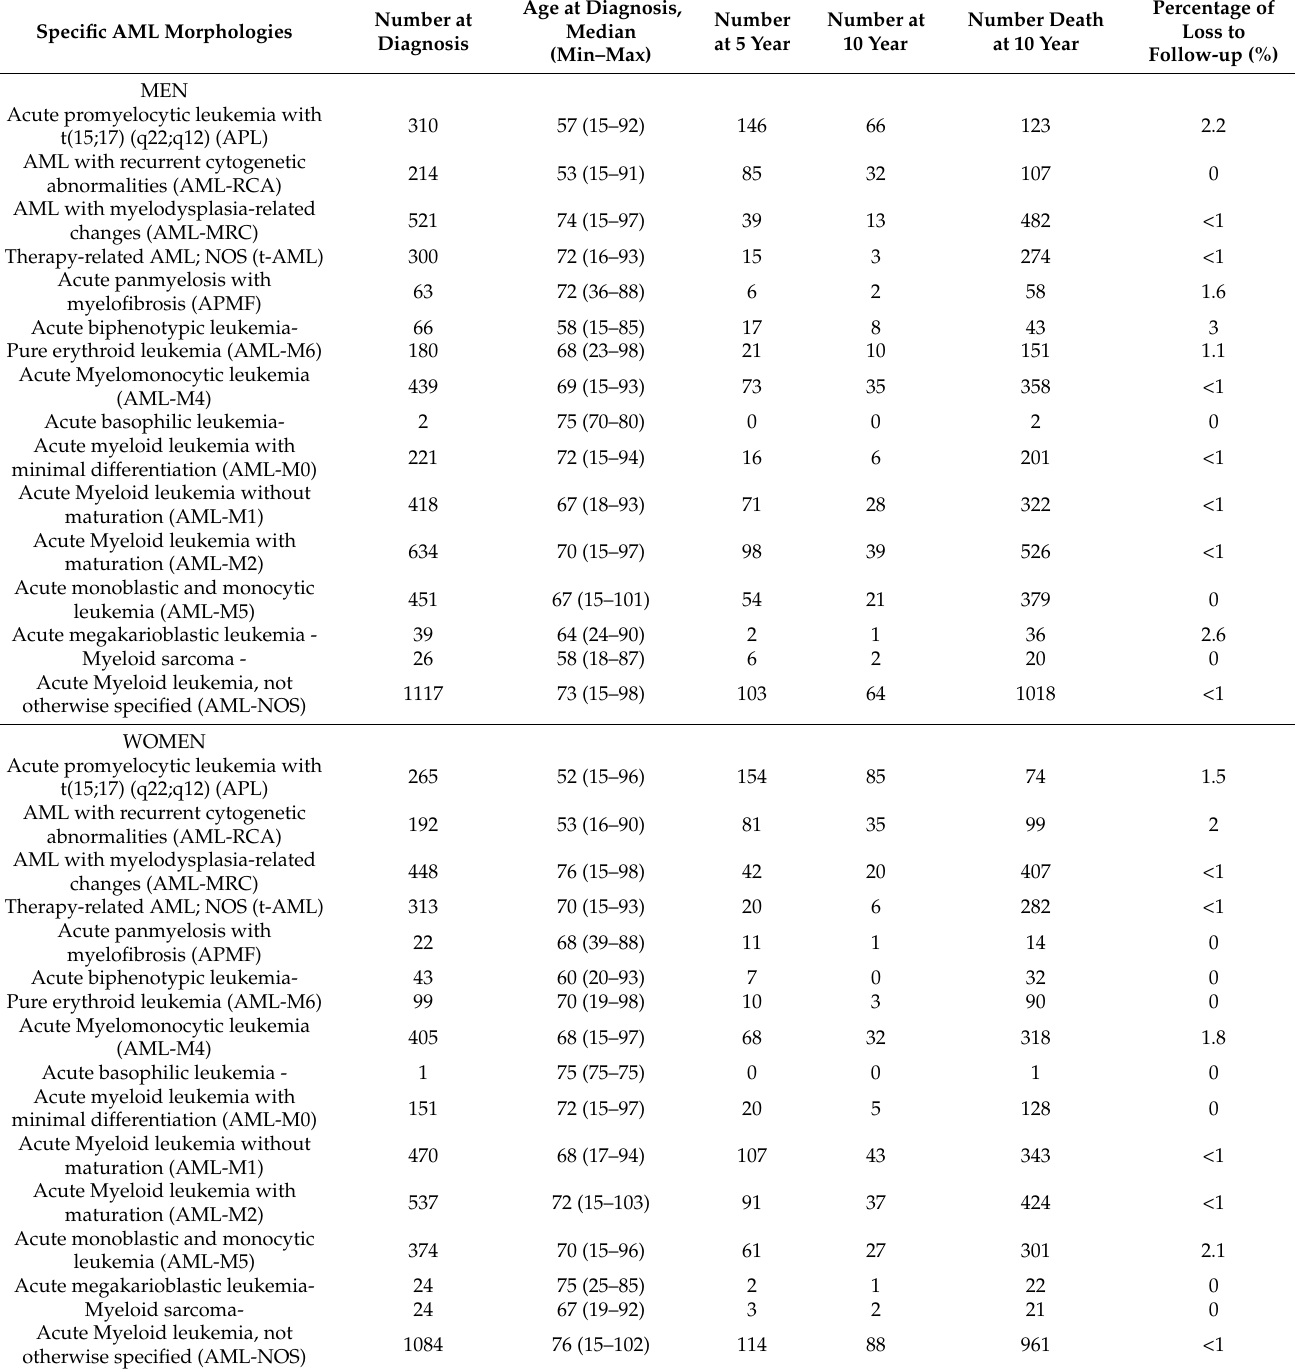
(49%) and AML-M1 (47%) (Table 1). The median age at diagnosis varied from 53 years for patients diagnosed with AML-RCA to 74 years for AML-MRC in men. In women themedian age at diagnosis varied from 52 to 76 years old, respectively, in APL and in AML-MRC (Table 2). Table 2. Characteristics of AML patients in the FRANCIM population-based study diagnosed on 1995–2015 by AML- subtype and sex: Numbers of cases, median Age, numbers of cases alive at 5, 10 years and deceased at 10 years (or on 30 June 2018) and % lost of follow-up (at 10 years or on 30 June